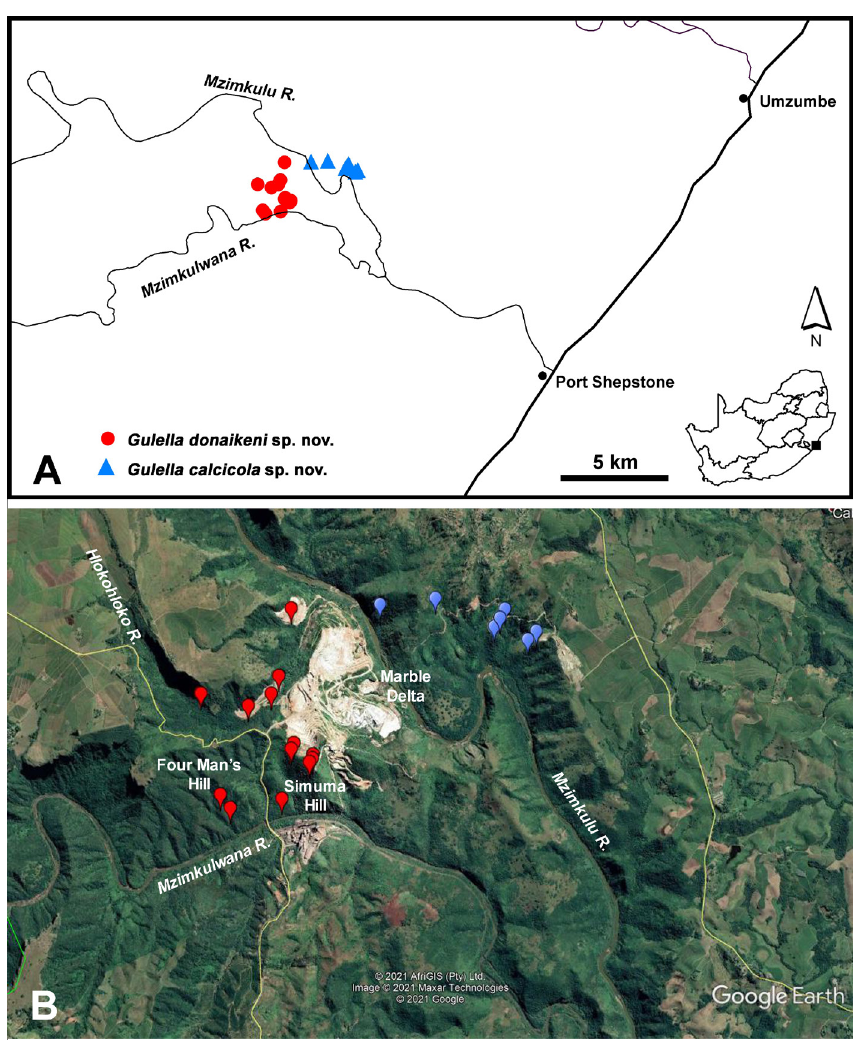
Fig. 6. A. Distribution map of Gulella donaikeni sp. nov. (red circles) and G. calcicola sp. nov. (blue triangles) in the Marble Delta region of southern KwaZulu-Natal. B. Google Earth image of distribution of G. donaikeni (red symbols) south of the Mzimkulu River and G. calcicola (blue symbols) north of the Mzimkulu